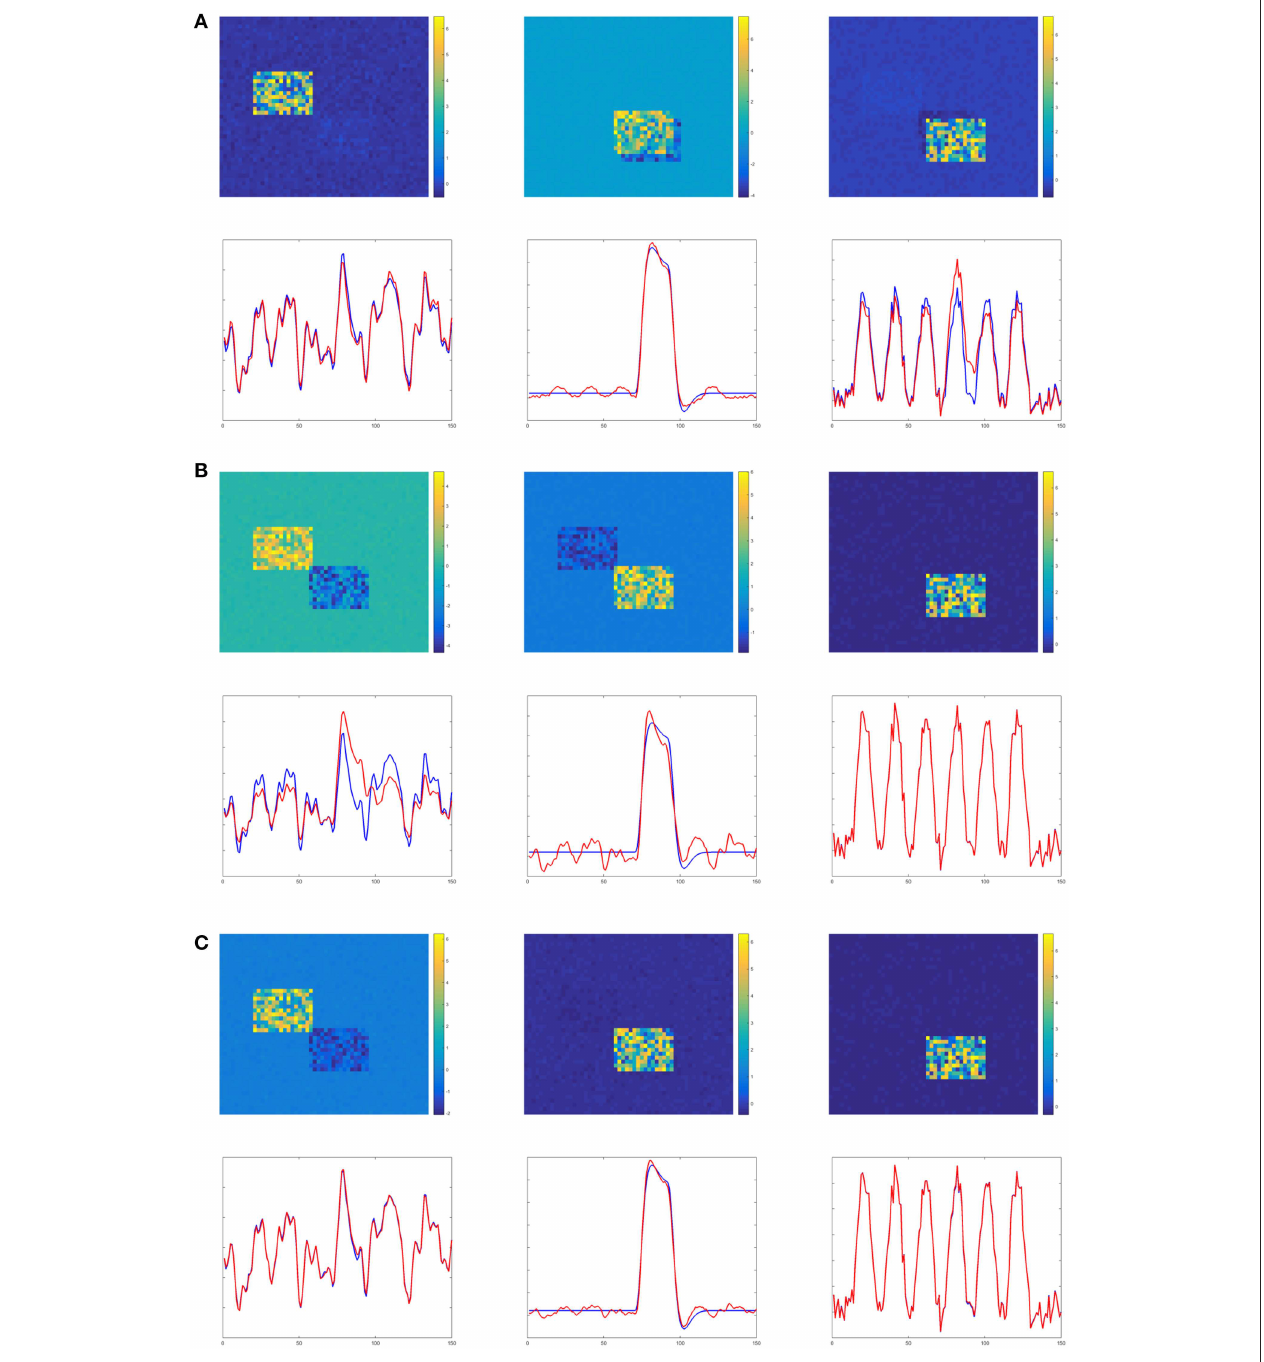
FIGURE 4 | Experiment A in the case of low noise, high overlapping and high collinearity. (A) TPICA. (B) PARAFAC. (C) Proposed Non-Gaussian penalized